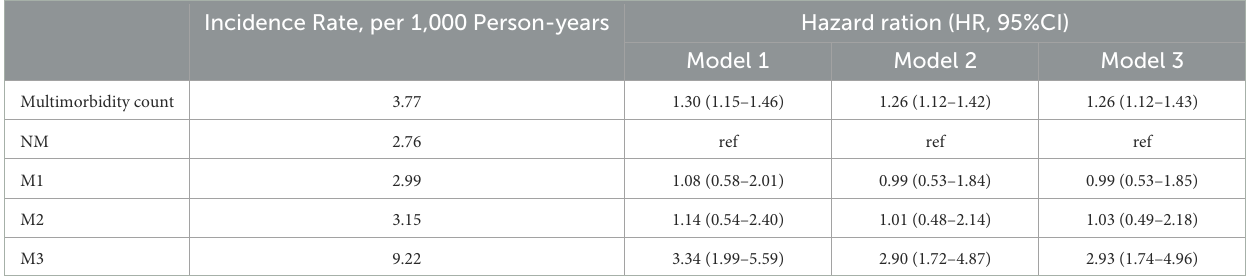
TABLE 3 Association between multimorbidity and MDs in the longitudinal